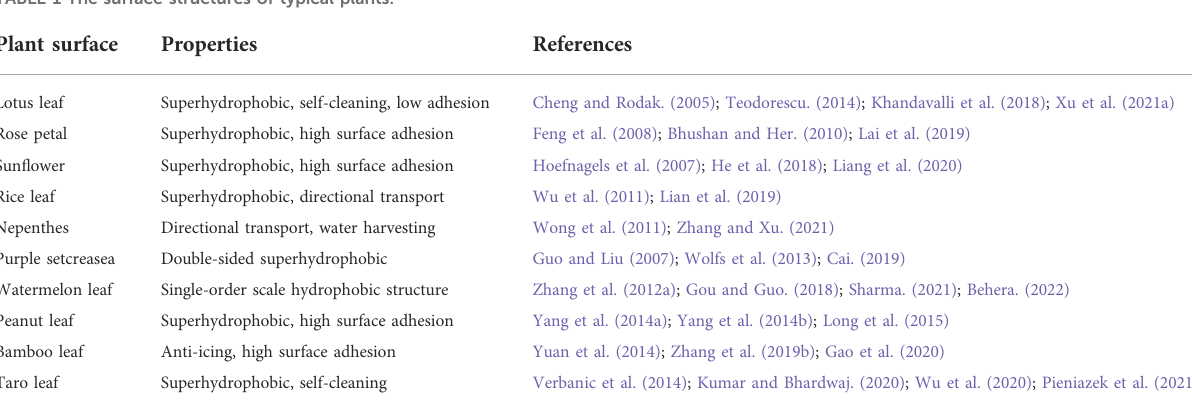
TABLE 1 The surface structures of typical